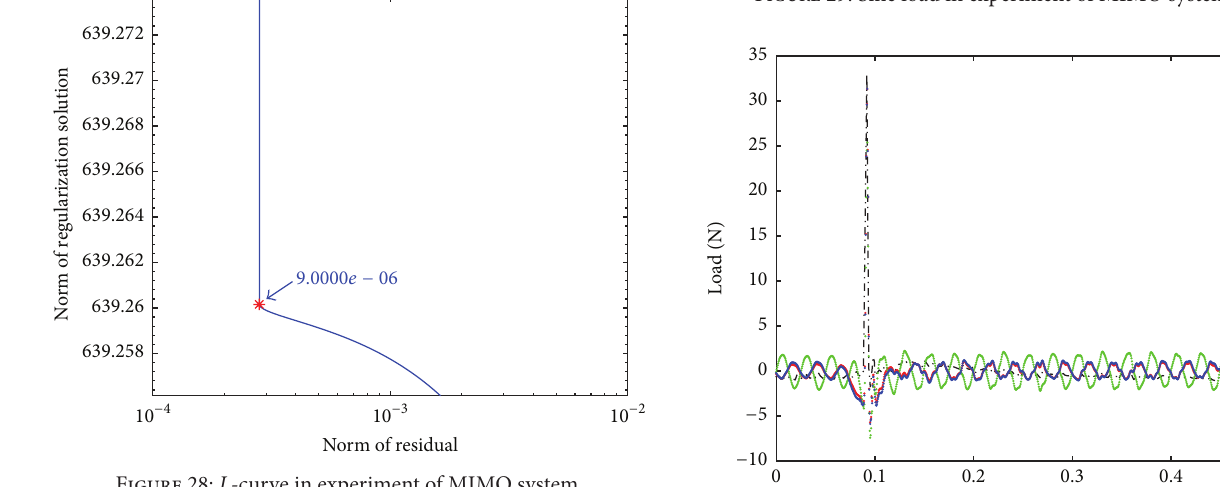
Figure 29: Sine load in experiment of MIMO system.